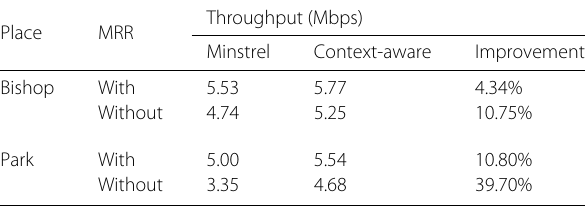
Table 6 In-field performance comparison